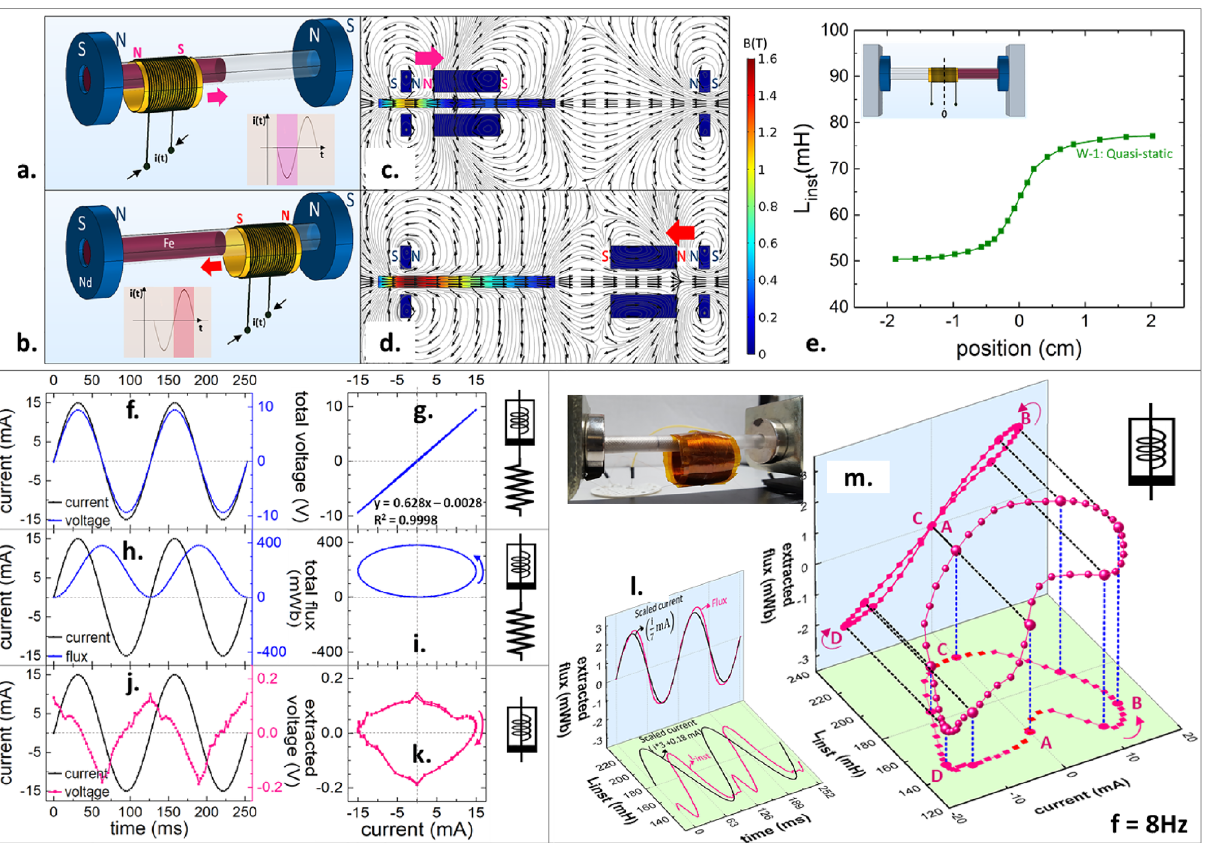
Figure 2. Experimental setup and results: ( a – d ) Two neodymium permanent magnets with like poles facing each other connected by a smooth shaft along which the fabricated winding can move freely; the core volume is partially filled by a ferromagnetic rod. Alternating negative ( a ) and positive ( b ) half-cycles in the sourced current result in alternating magnetic poles on the winding thus periodically switching the direction of force exerted on it by the permanent magnets. A periodic back and forth winding motion results from this force profile. Simulated magnetic field pattern for winding positioned as in (‘ a ’) and (‘ b ’) shown in ( c , d ), respectively. ( e ) Quasi-static inductance measurements on W-1 as a function of the position of the winding relative to the core; zero-reference position in the setup shown in the inset. ( f , g ) Total voltage measured across the terminals of the winding, W-1 by sourcing sinusoidal current, ( h , i ) Total flux calculated as the time integral of the total voltage measured, ( j , k ) (Mem)inductive voltage extracted from the total voltage by subtracting resistive voltage, ( l , m ) Extracted (mem)inductive flux calculated as the time integral of the extracted (mem)inductive voltage, and instantaneous dynamic inductance calculated as the ratio of extracted (mem)inductive flux and current. Inset on the top-right shows a picture of the experimental